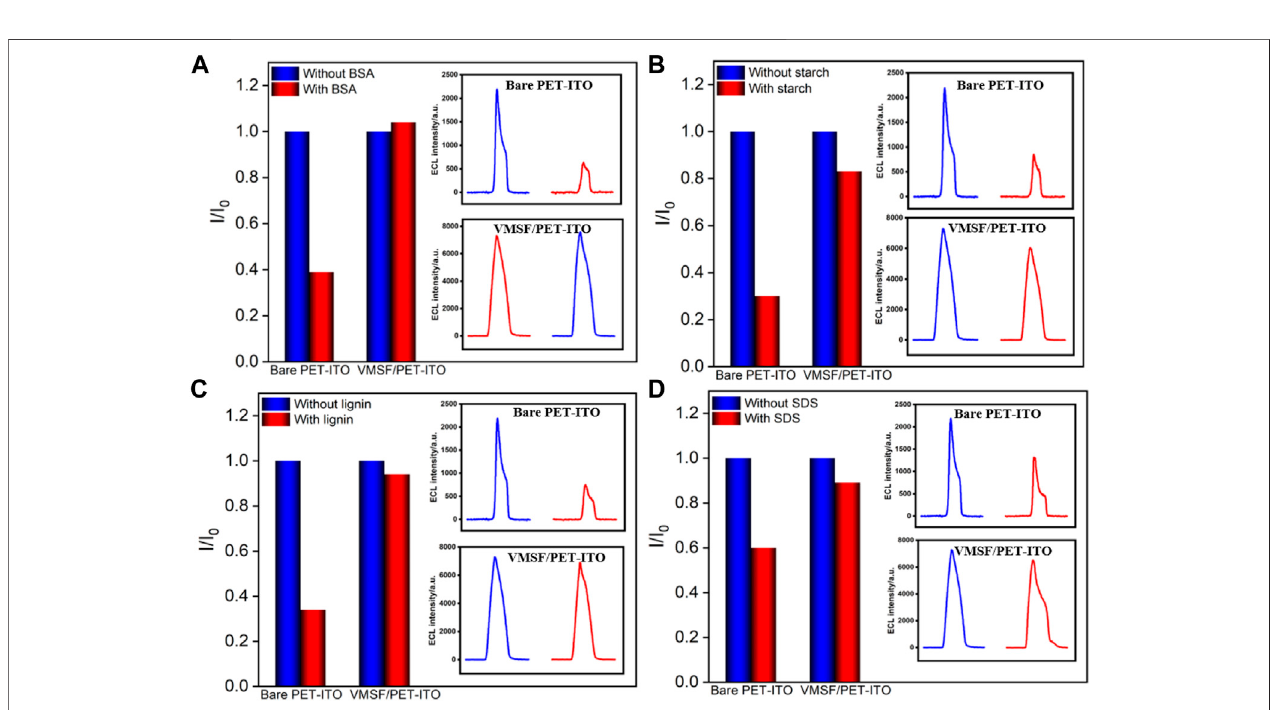
FIGURE 7 | Normalized ECL intensity ratio on bare PET-ITO or VMSF/PET-ITO toward clindamycin (30 μ M). I and I 0 represent the ECL intensity obtained in the absenceandpresentof50 μ g/ml (A) BSA, (B) starch, (C) lignin,or (D) SDSinPBS(0.01 mol/L,pH=7).TheinsetsarethecorrespondingECLintensityobtainedonbare PET-ITO and VMSF/PET-ITO in the absence or presence of fouling species.